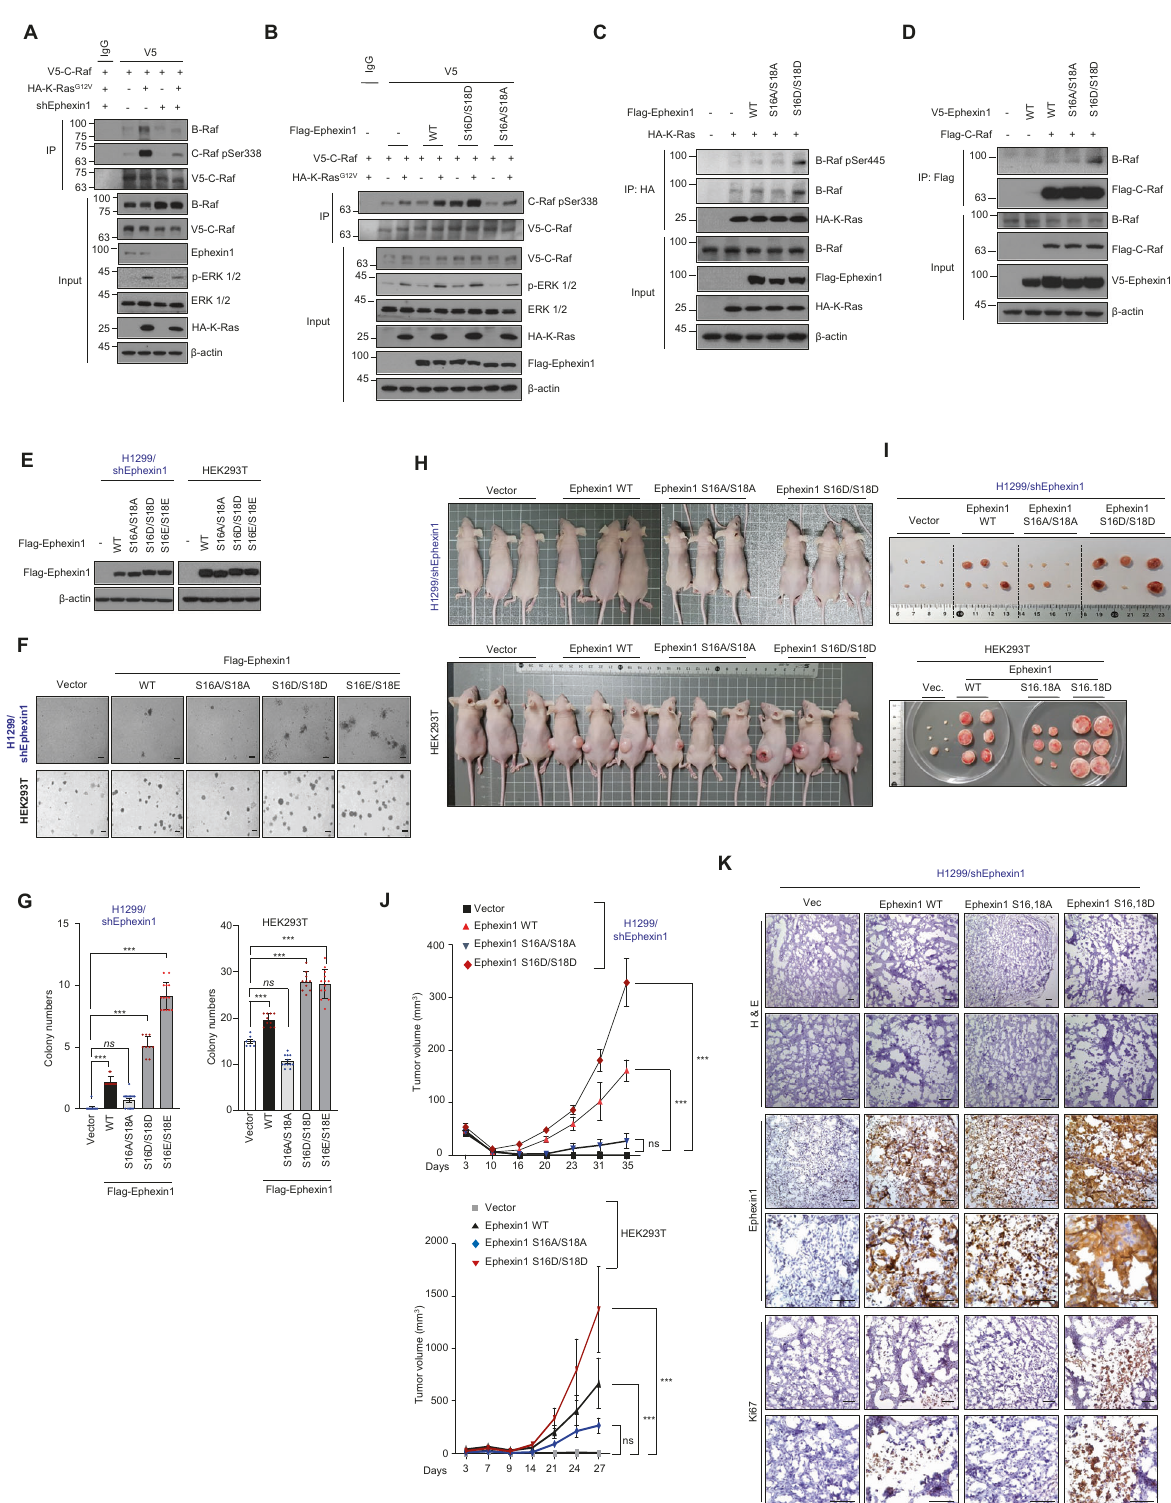
EGF treatment, WT Flag-Ephexin1 interacted strongly with WT K- Ras, but S16A/S18A mutant failed to do so (Supplementary Fig. S8A). Moreover, an Ephexin1 phosphomimetic mutant (S16D/ S18D) is readily bound to K-Ras (Supplementary Fig. S8B). These results indicate that phosphorylation of these serine residues is important for the interaction between Ephexin1 and K-Ras. Cell Death and Disease (2021)